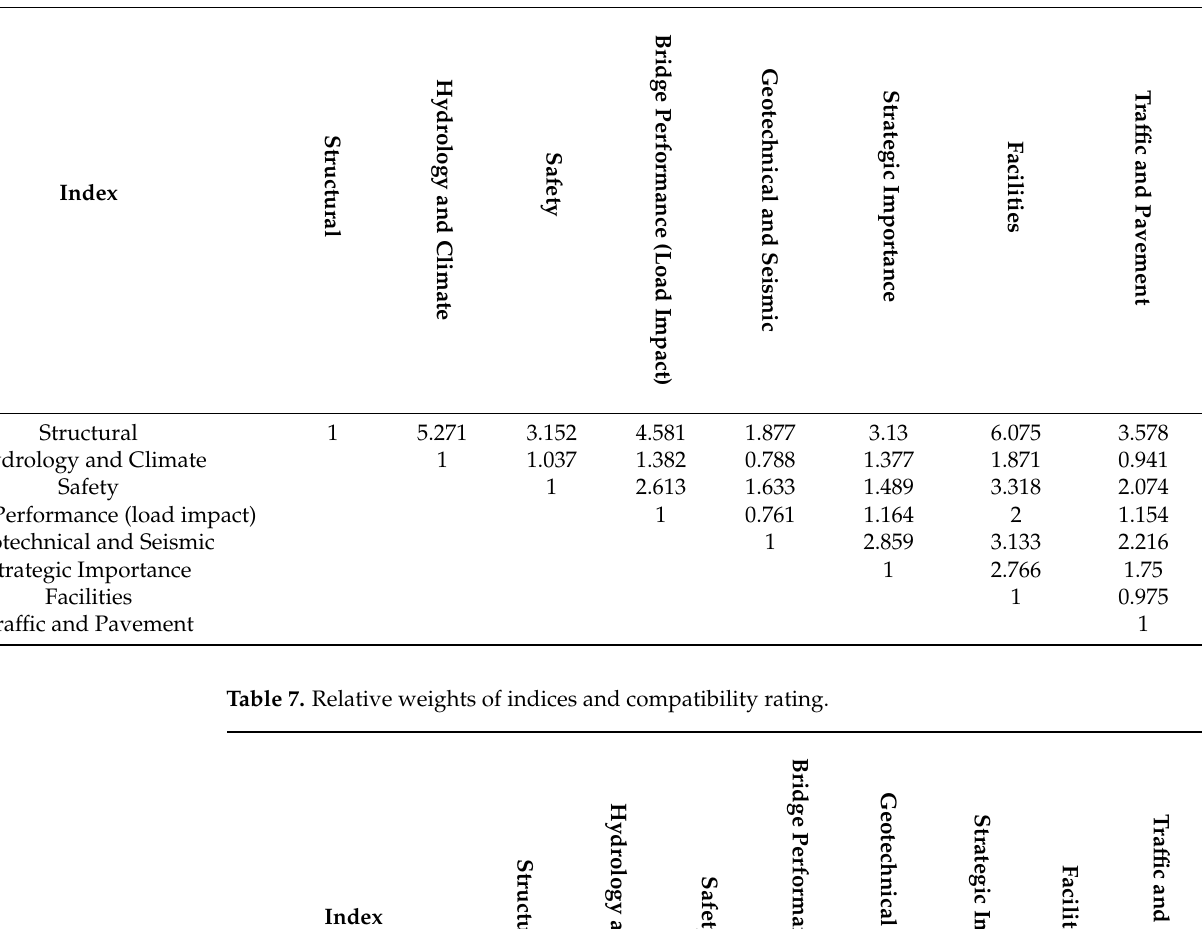
Table 6. Relative importance of indices based on a survey of experts.